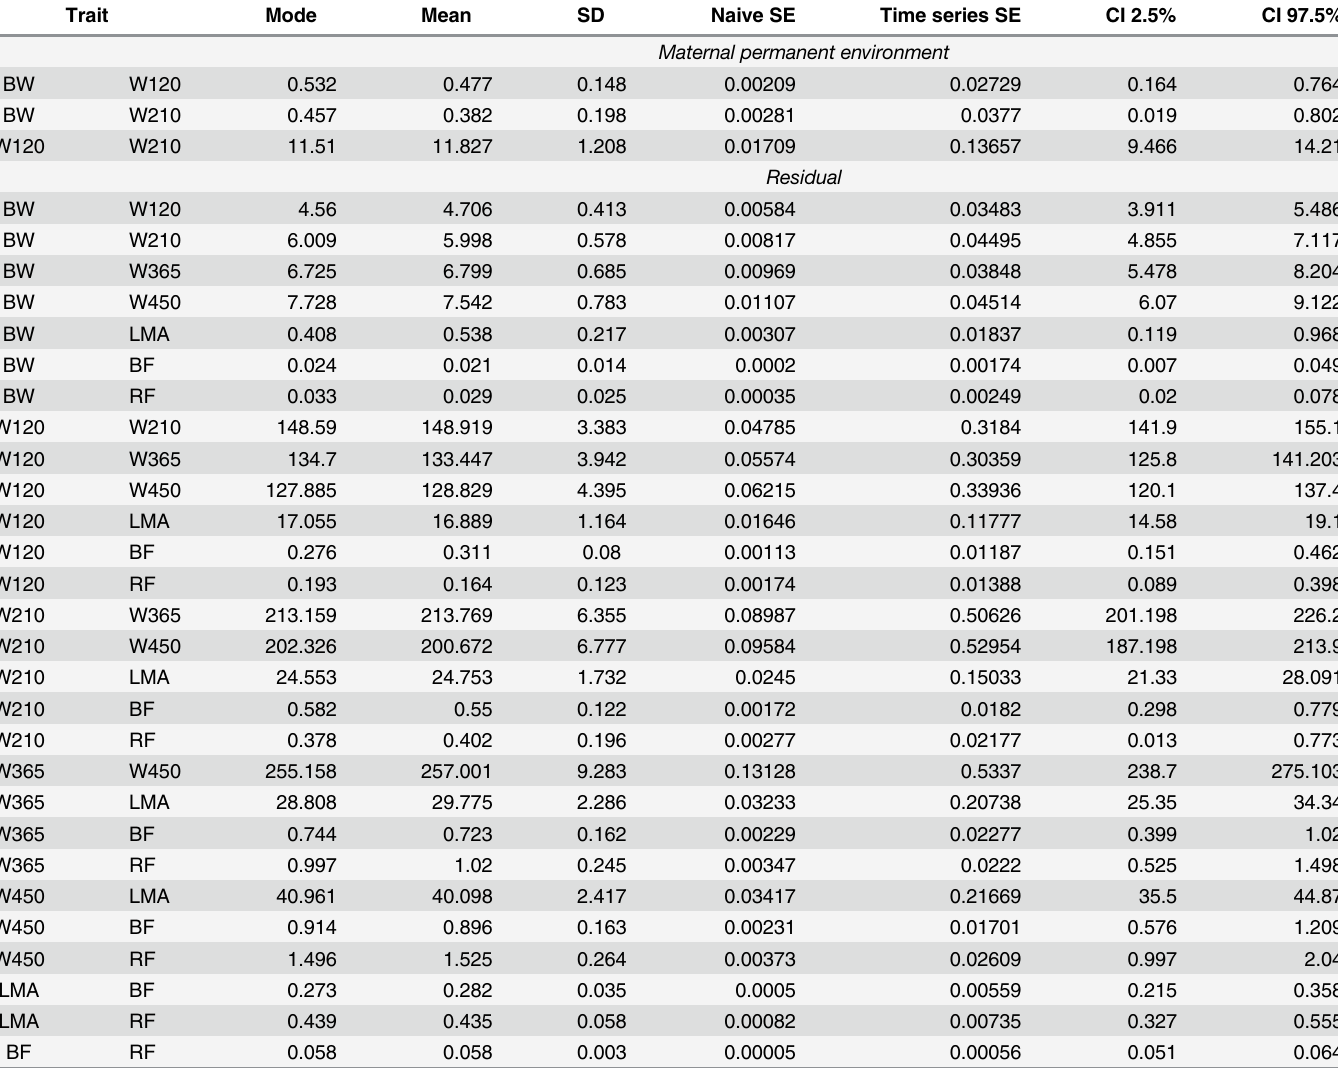
Table 5. Marginal posterior distributions of the maternal permanent environmental and residual covariances among growth and carcass traits in Polled Nellore cattle.